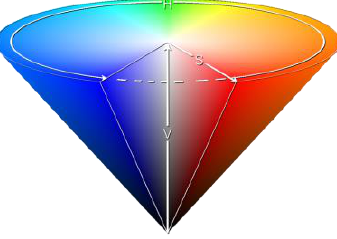
Figure 5: The HSV colour system used in our algorithm